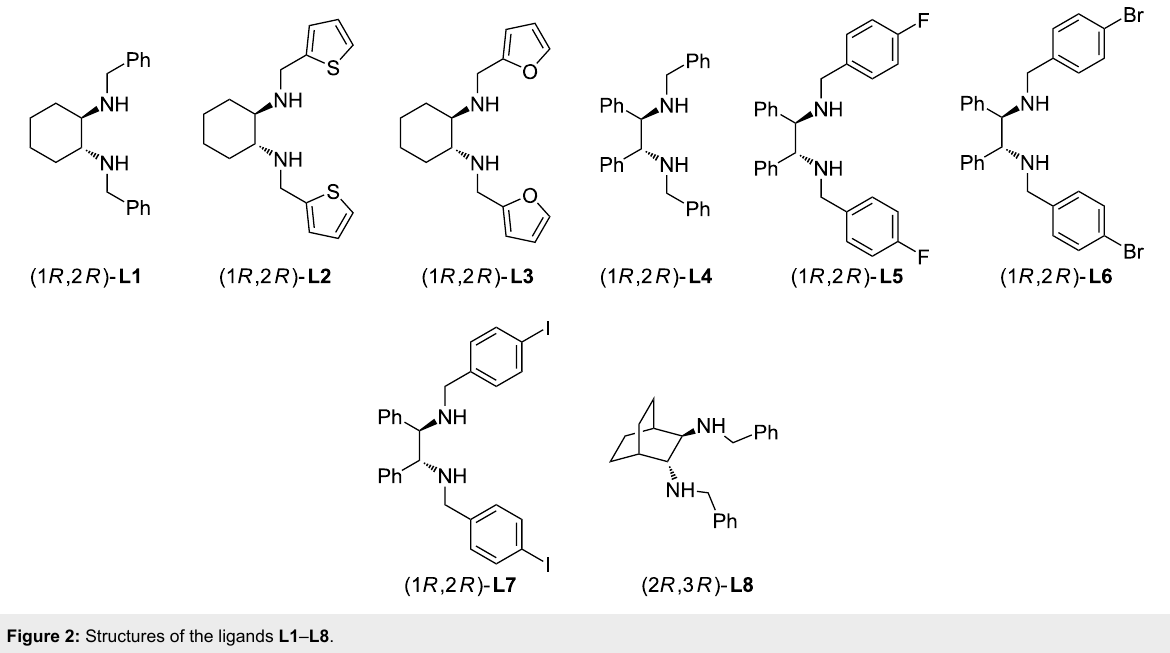
Figure 2: Structures of the ligands L1 – L8 .